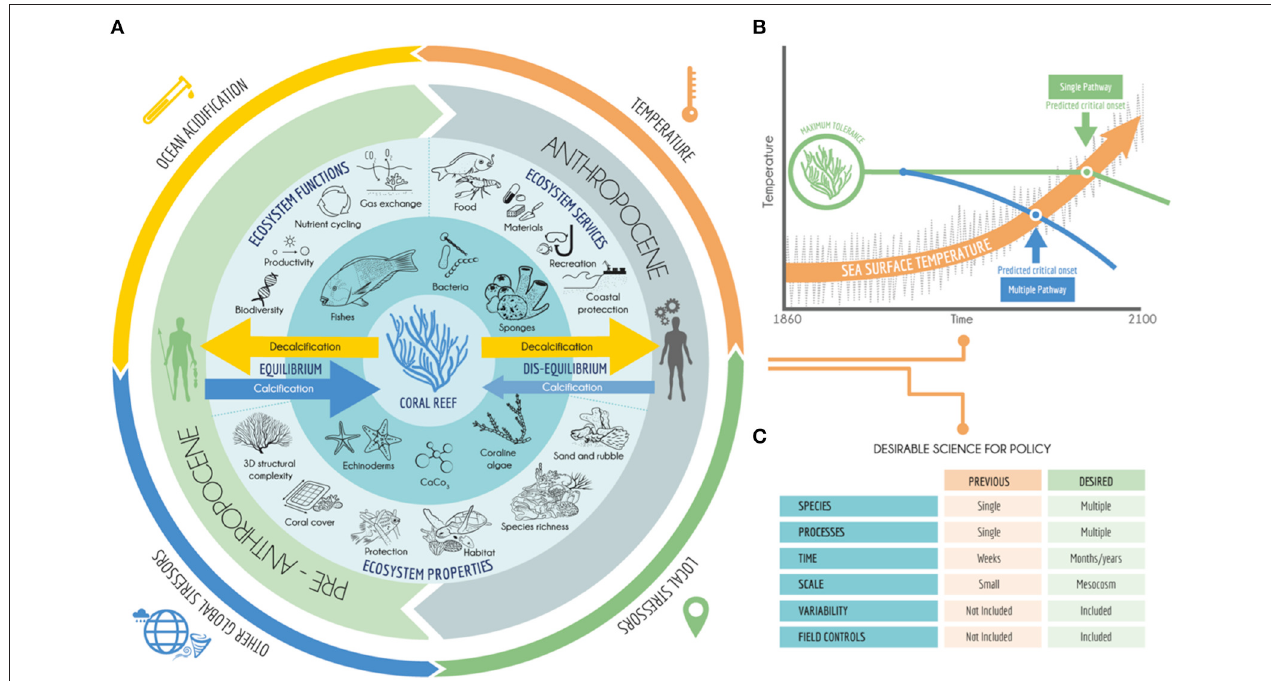
FIGURE 1 | (A) A conceptual framework describing ecological processes that contribute to coral reef growth and maintenance vs. the biological and anthropogenic factors that can work against these processes. The inner circle depicts important coral reef ecosystem constituent species. The next circle represents ecosystem features that are important to people. The next circle, along with the arrows showing calcification and decalcification illustrates that in pre-Anthropocene times coral reefs experienced net growth where calcification probably exceeded decalcification; the balance has been reversed at some time during the Anthropocene. The outermost circle captures key environmental stressors that affect coral reef health and determine whether coral reefs grow or decline. Panel (B) demonstrates how increased ecological sensitivity due to multiple stressors (blue line) can lower the threshold at which sea surface temperature causes harm to coral reefs and thus hastens the onset of damages. Panel (C) shows the dimensions along which new science must be expanded, and how, in order to provide more policy relevant science (inspired by Cinner et al.,